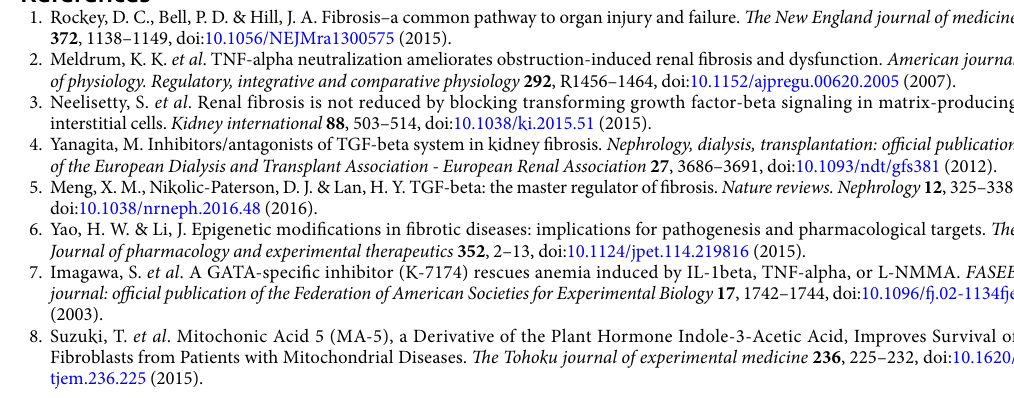
Table 1b. Statistical